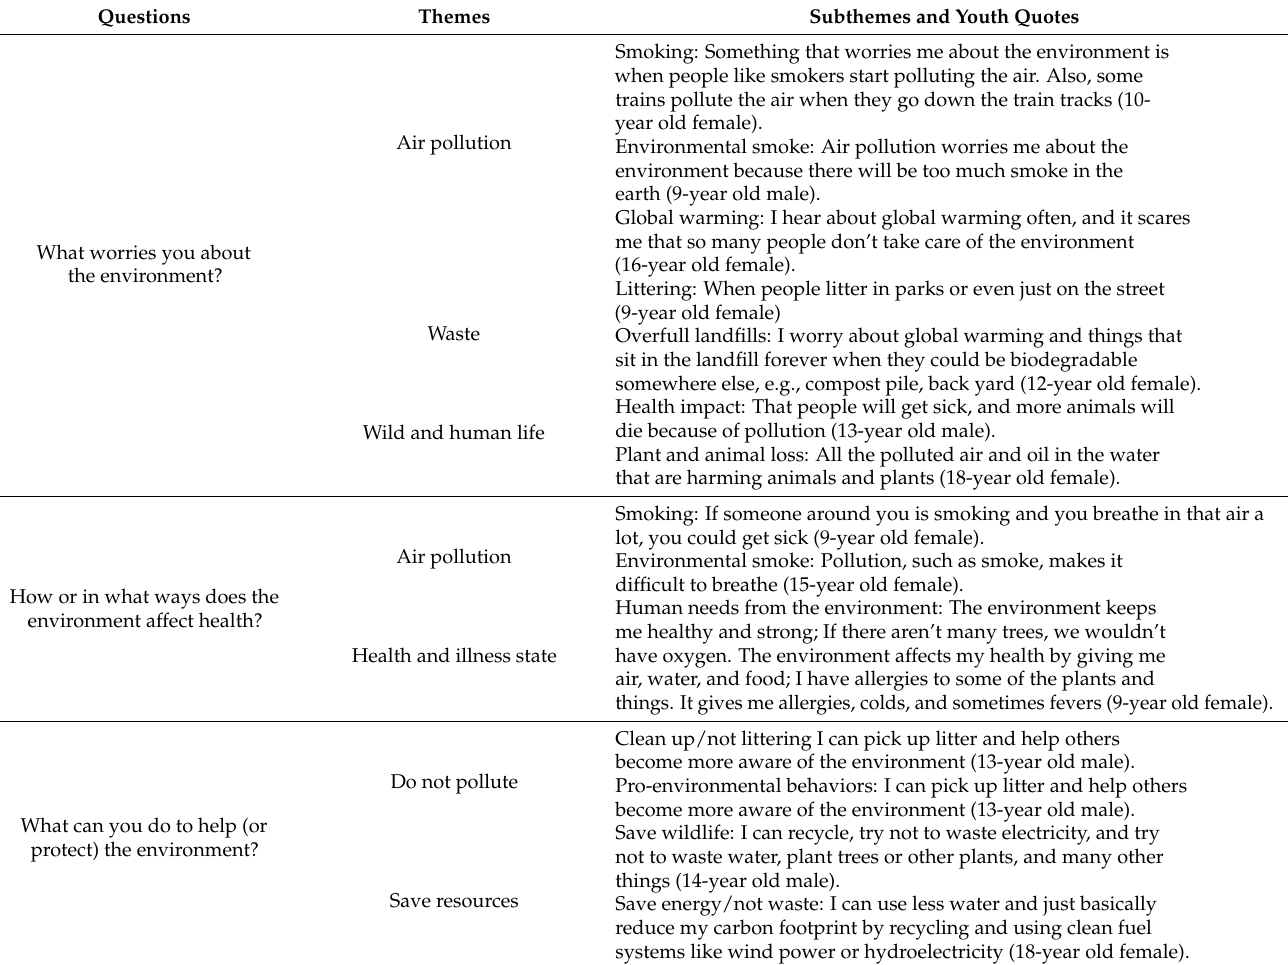
Table 2. Qualitative Themes and Subthemes ( n = 452).